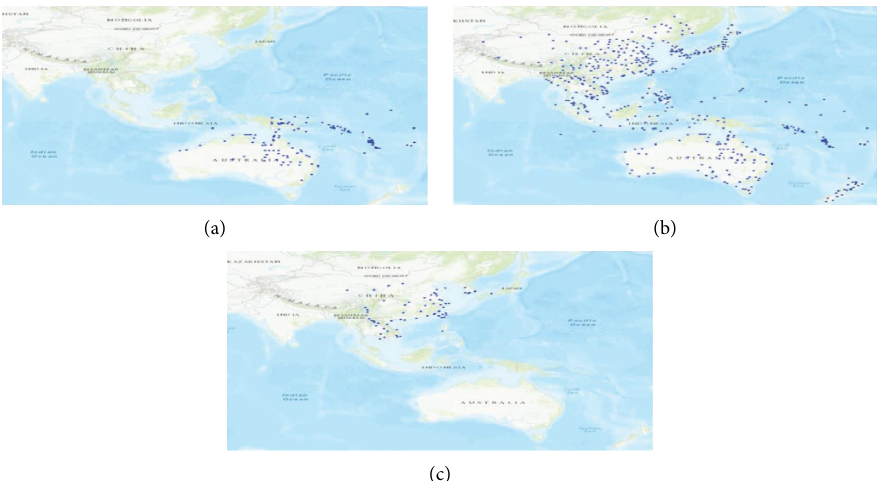
Figure 9: LCC of the East and Southeast Asia-Oceania components after isolation from the network. Te blue dots are the remaining airports after attacks on the world air transportation network (a) strength attack, (b) weighted betweenness attack, and (c) weighted PageRank attack. Te LCC isolated by the strength attack covers the countries in Oceania. Te LCC separated by the weighted PageRank attack covers East and Southeast Asia major countries. In contrast, the LCC isolated by the weighted betweenness attack covers all the regions of the initial component.